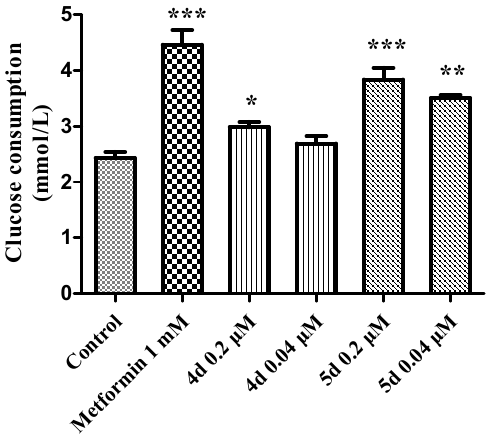
Figure 3. Compounds 4d and 5d promoted glucose consumption in HepG2 cells. The data are the average of three independent experiments, each performed in duplicated. * p < 0.05, ** p < 0.01, and *** p < 0.001 vs.